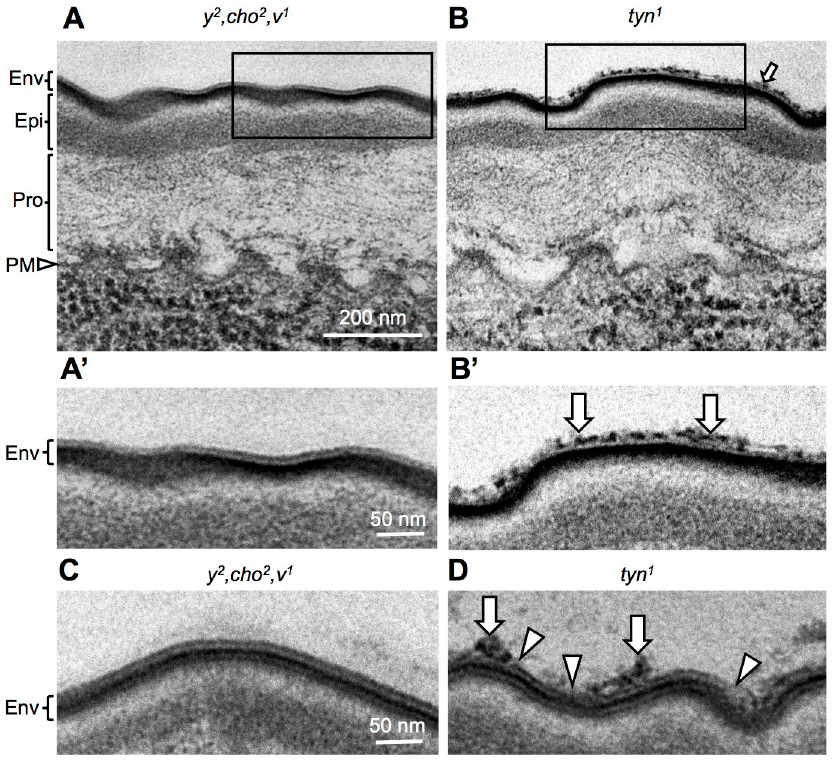
Fig 4. Ultrastructure of the epidermis in y 2 , cho 2 , v and the tyn 1 mutant. TEM images of epidermis in stage 17 embryos. (A) Three cuticle layers formed on the plasma membrane of epidermal cells (PM, arrowhead): the outermost envelope (Env), intermediate epicuticle (Epi), and innermost procuticle (Pro). (B) The surface of the envelope layer of the tyn 1 mutant was disorganized (arrow). (A’), (B’): Enlarged views of the region indicated by a rectangle in (A) and (B), respectively. In control samples, the five sublayers constituting the envelope were observed clearly, as alternating electron-dense and lucid layers in (C). (D) In the tyn 1 mutant, one or two surface sublayers were broken in many regions (arrowheads), causing a rough surface with extensive debris (arrows). Scale bar: 200 nm for (A), (B) and 50 nm for (A’), (B)’, (C), (D).